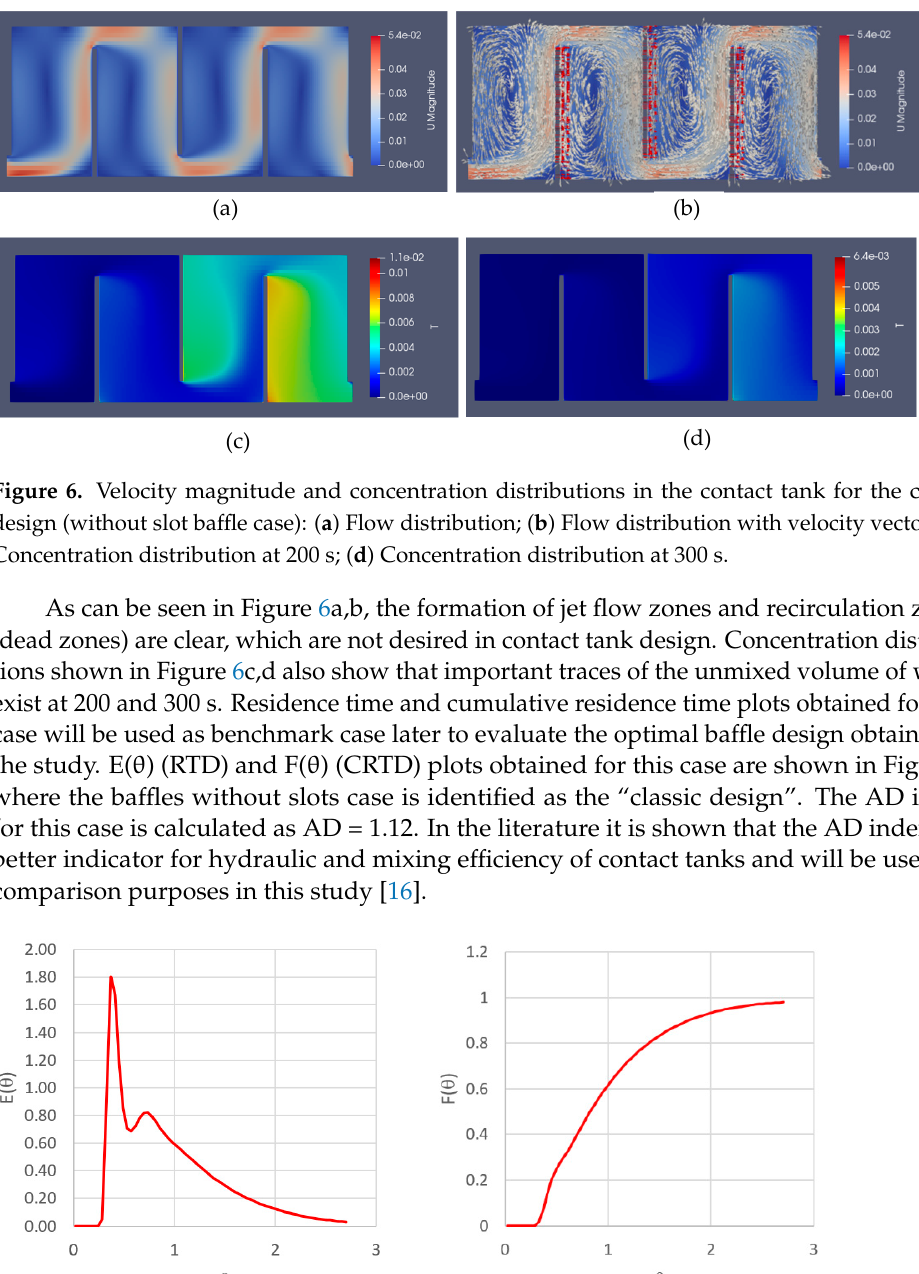
Figure 5. Contact tank baffle configuration for baffles without slots.